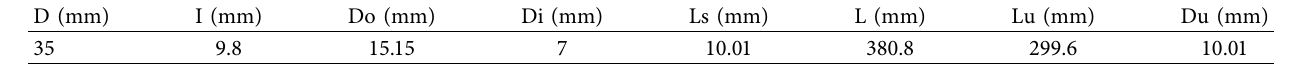
Table 1: The size of different sections of the investigated hydrocyclone [42].